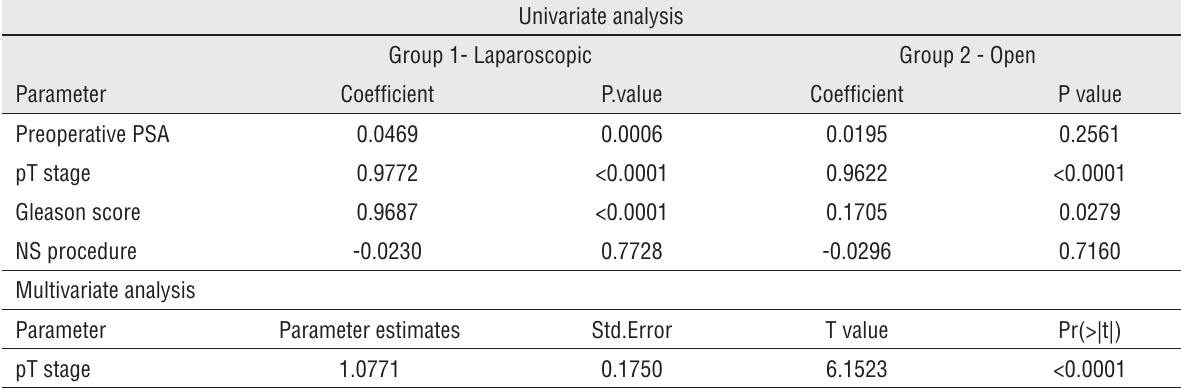
Table 5 - Linear regression model for parameters association with positive surgical margin fi nding.